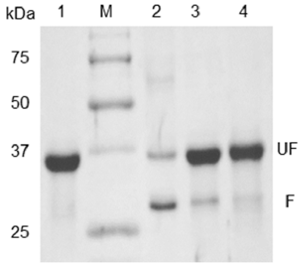
Figure 1. Gel-shifting of mt OmpT DB on SDS-PAGE: Lane 1— mt OmpT DB inclusion bodies (IBs), Lane M—protein molecular weight marker. mt OmpT DB after refolding in DodMe 2 NPrSO 3 detergent buffer